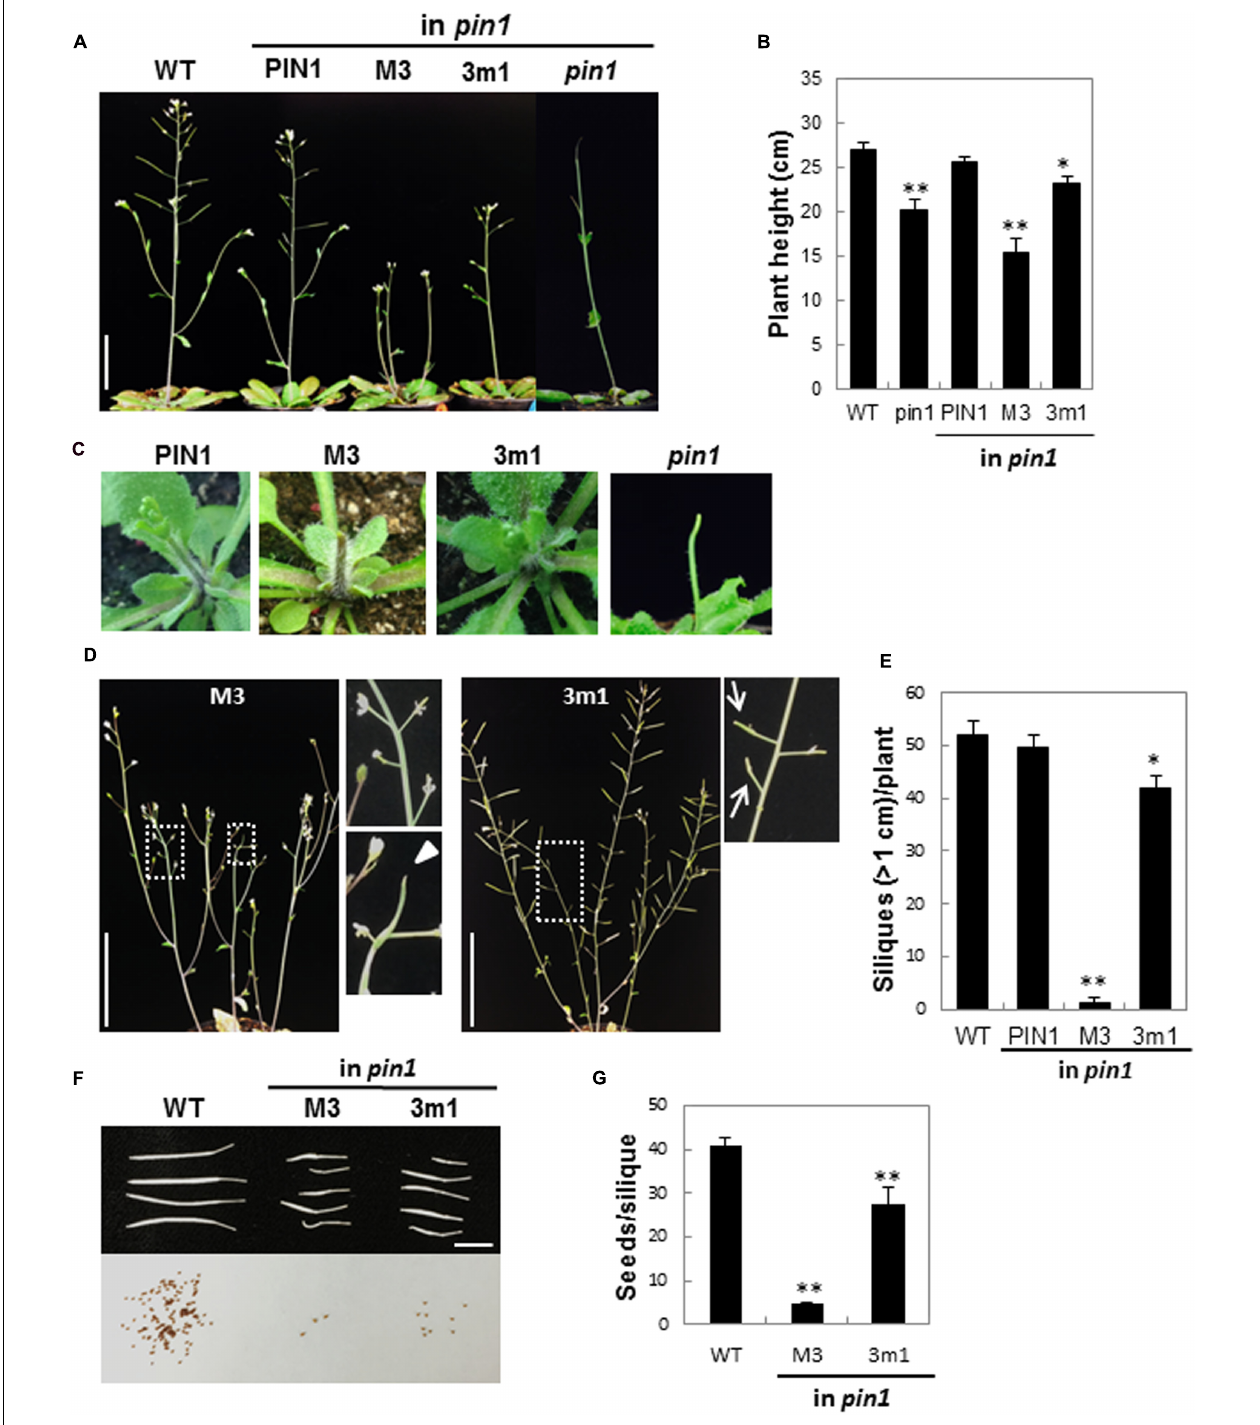
FIGURE 4 | Effect of M3 or 3m1 mutation of PIN1 on reproductive development. (A) Inflorescence stems of WT, homozygous pin1 , and homozygous pin1 complemented with PIN1 ( ProPIN1:PIN1:GFP ), M3PIN1(M3, ProPIN1:M3PIN1:GFP ), and 3m1PIN1 (3m1, ProPIN1:3m1PIN1:GFP ). Bar = 5 cm. (B) Average height of the plants in (A) . Data represent means ± SE ( n = 7–10). Differences are significant from WT value at ∗ P < 0.05 and ∗∗ P < 0.005. (C) Early developing inflorescence stems. (D) Defects in reproductive organs by M3 or 3m1 mutation. Arrowhead indicates the defect in the stem tip. Arrows indicate defects in siliques. (E) Number of silique over 1-cm long. Data represent means ± SE ( n = 5–8 plants). Differences are significant from WT value at ∗ P < 0.05 and ∗∗ P < 0.005 in t -test. (F) Siliques and seeds from WT and strong phenotypic siliques of M3 and 3m1 plants. Seeds were harvested from the siliques shown in the upper photograph. Bar = 5 mm. (G) Number of seeds per silique. Data represent means ± SE ( n = 8–20 siliques). Differences are significant from WT value at ∗∗ P < 0.005 in t -test.